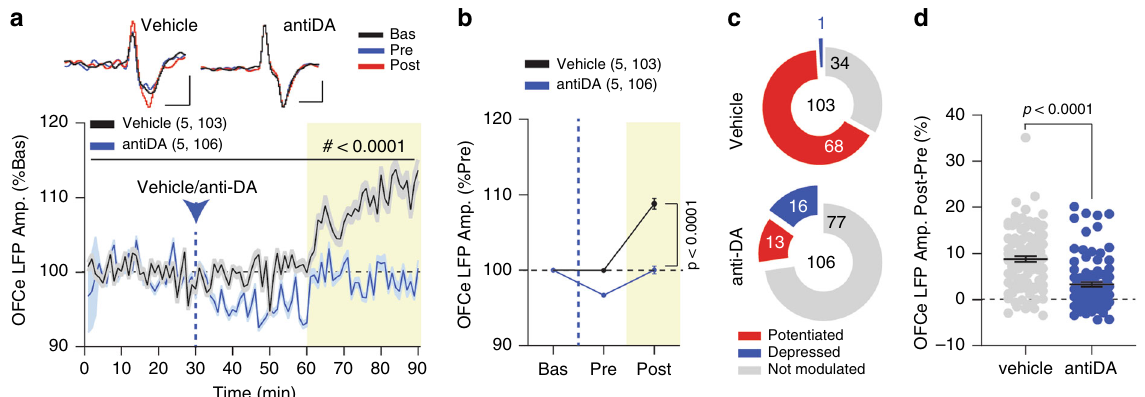
Fig. 5 Dopaminergic antagonists prevent cocaine-induced OFC-DMS potentiation. a Time-course of normalized OFCe LFP amplitude expressed as a percentage of baseline prior to vehicle or anti-DA i.p. injections (RM two-way ANOVA; time main effect F (3.568,738.7) = 19.79, p < 0.0001, drug main effect: F = 133.8, p < 0.0001, time Χ drug interaction: F = 14.18, p < 0.0001). Scale bar: 20 ms, 5 μ V. b Binned OFCe LFP responses (RM two-way (1,107) (89,18423) ANOVA, time main effect: F (1.277,264.3) = 150.4, p < 0.0001; drug main effect: F (1,207) = 122.3, p < 0.0001; time Χ drug: F (2,414) = 75.39, p < 0.0001; followed by between-subject Bonferroni post hoc test antiDA vs Veh; 1 – 30: t (621) = 0, p > 0.9999; 31 – 60: t (621) = 5.923; 61 – 90: t (621) = 15.87). c Pie-charts reporting the number of signi fi cantly potentiated or depressed and not modulated OFCe LFP responses. d Change in OFCe LFP amplitude (Post - Pre) expressed as percentage of baseline (two-tailed Mann – Whitney U = 2627). Data are represented as single points and/or as mean ± SEM. N , n indicate number of mice and OFCe LFPs included in the